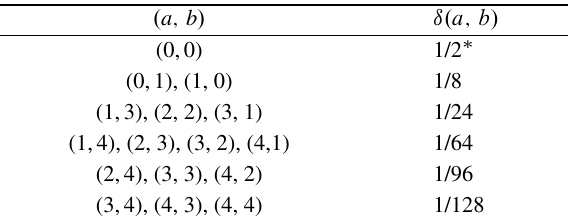
Table 8 Values of ııı. a ; b / for different depths.